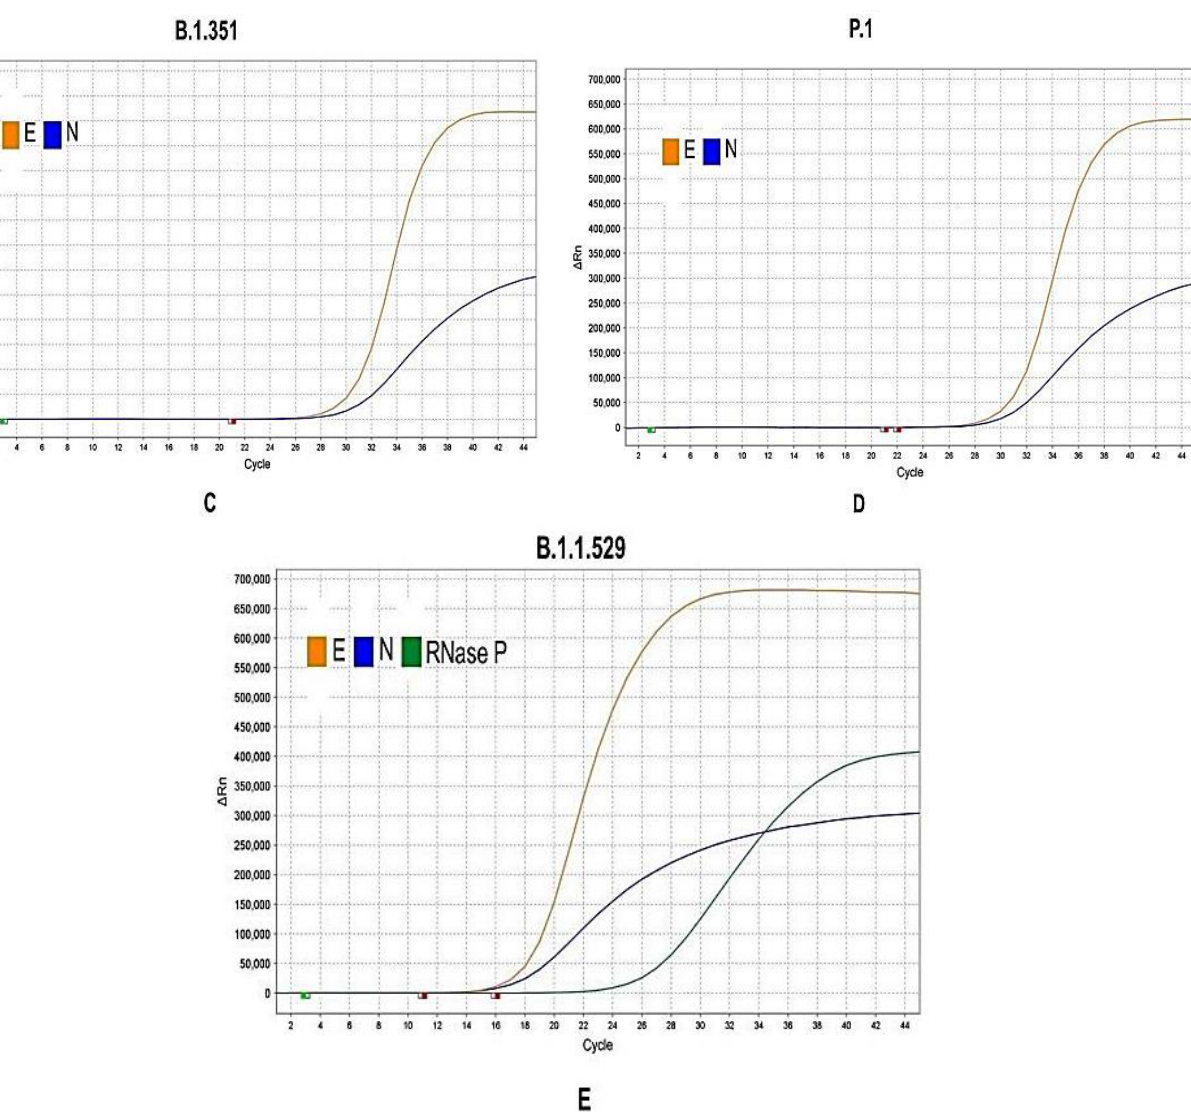
Figure 3. Detection of the SARS-CoV-2 variants of concerns by Bangasure TM multiplex rRT-PCR